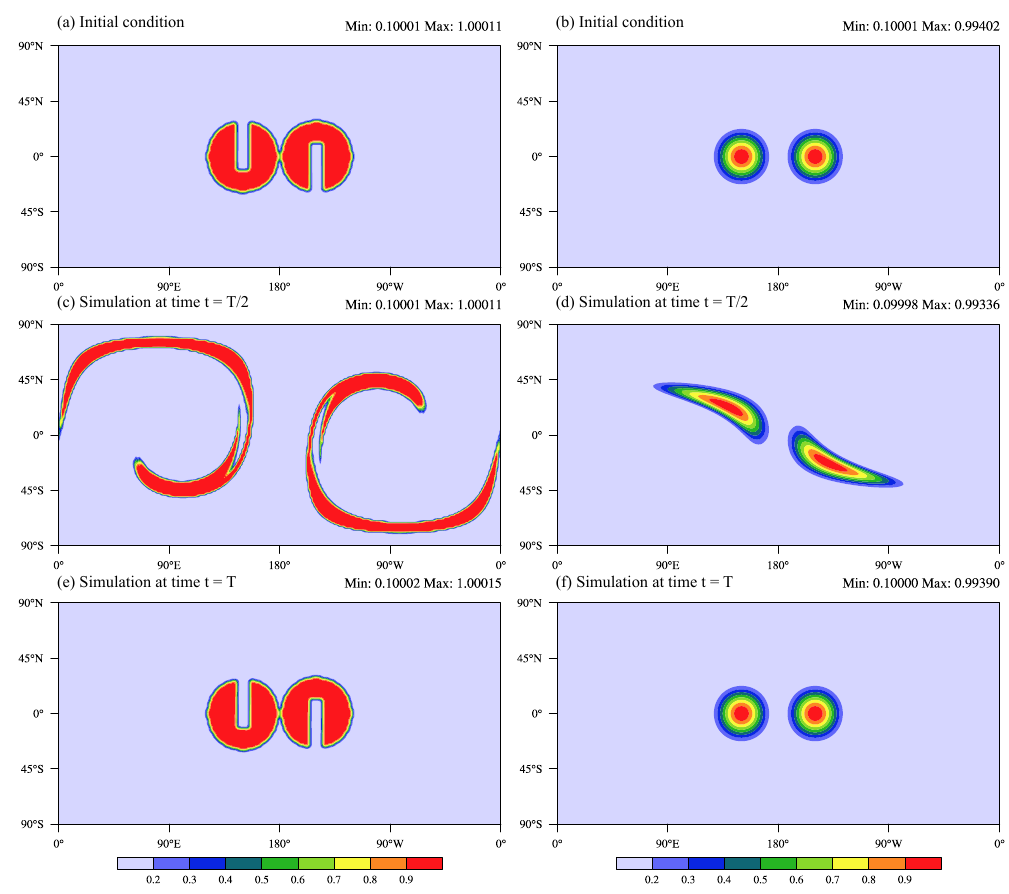
Figure 10. Results from deformation flow test cases. (a) is the initial slotted cylinders for the non-divergent flow test, and (b) is the initial cosine hills for the divergent flow test. (c) and (d) are the simulated distributions at time t = T/ 2 with maximum deformation. (e) and (f) are the final distributions at time t = T . The model grid resolution is 1 . 5 ◦ × 1 . 5 ◦ , and time step size is T/ 600.